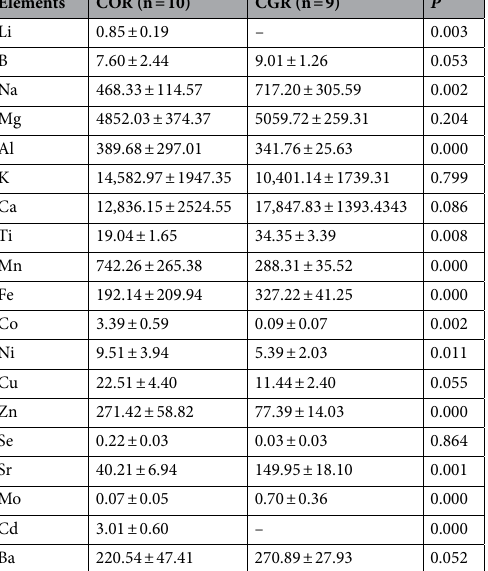
Table 1. Average of mineral element concentrations (μg/g) of 10 COR and 9 CGR samples. Data were expressed as the mean ± SD. —means not checked out. The P < 0.05 reflects the statistical significance of the difference between